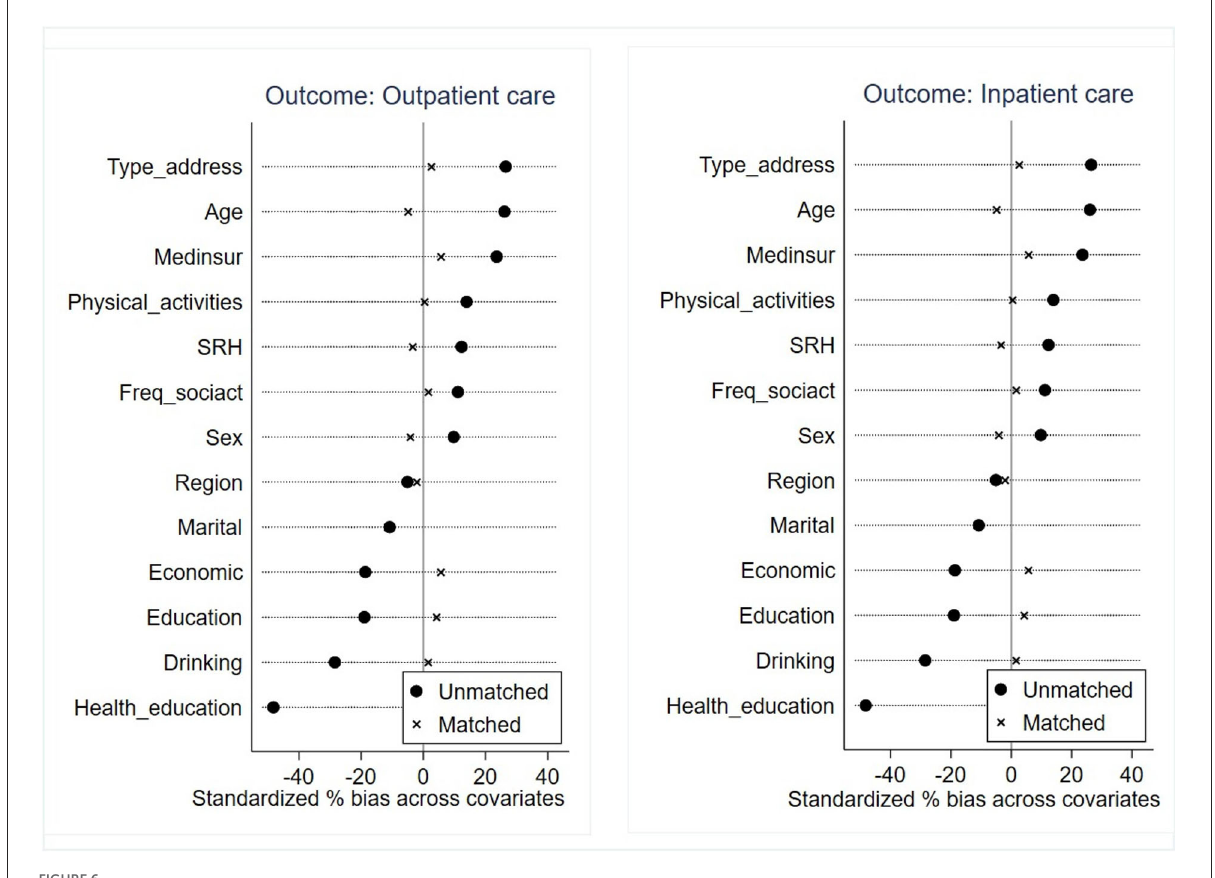
FIGURE6 Balance test of the covariates.